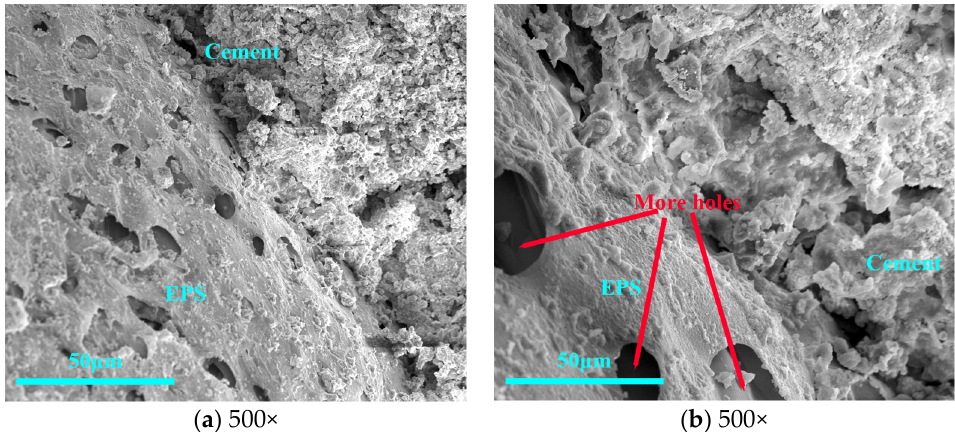
Figure 10. Microstructure of interface treated with organic acid interface agent and VAE emulsion.